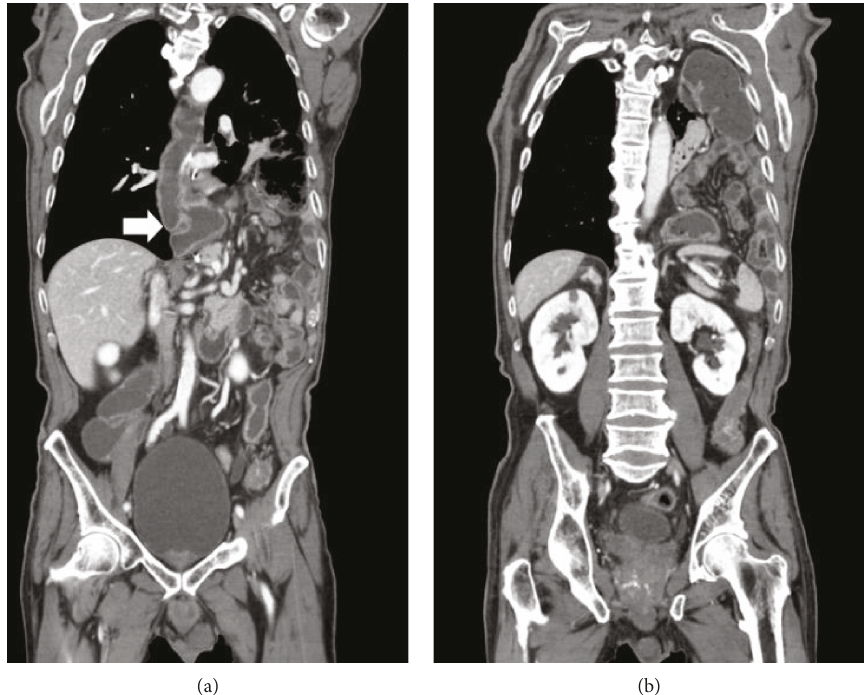
Figure 1: Coronal CT scan showing the massive transdiaphragmatic herniation of abdominal viscera in the left hemithorax. (a) The gastric conduit on the right of the herniated viscera (arrow). (b) The left hemithorax totally occupied by the abdominal